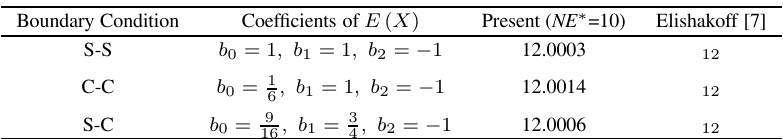
Table 1 Critical load for an axially FG uniform beam